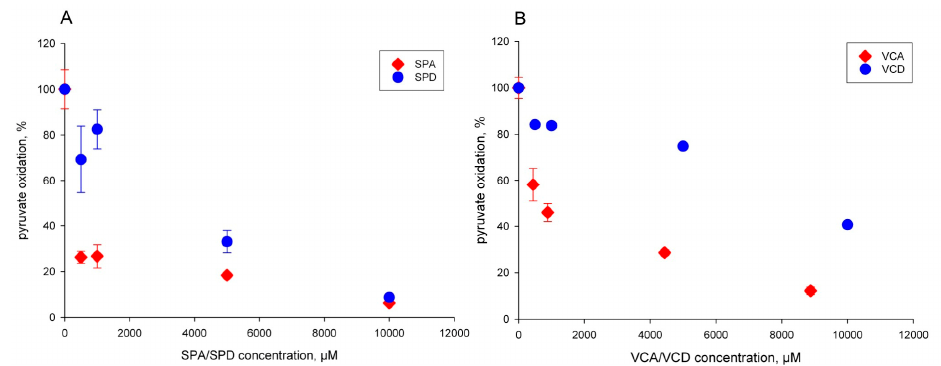
Figure 3. Inhibition of pyruvate oxidation of isolated rat liver mitochondria by derivatives of valproic acid. ( A ) Red diamonds, SPA; blue circles, SPD. ( B ) Red diamonds, VCA; blue circles, VCD. Experimental conditions as indicated in the legend to Figure 2.